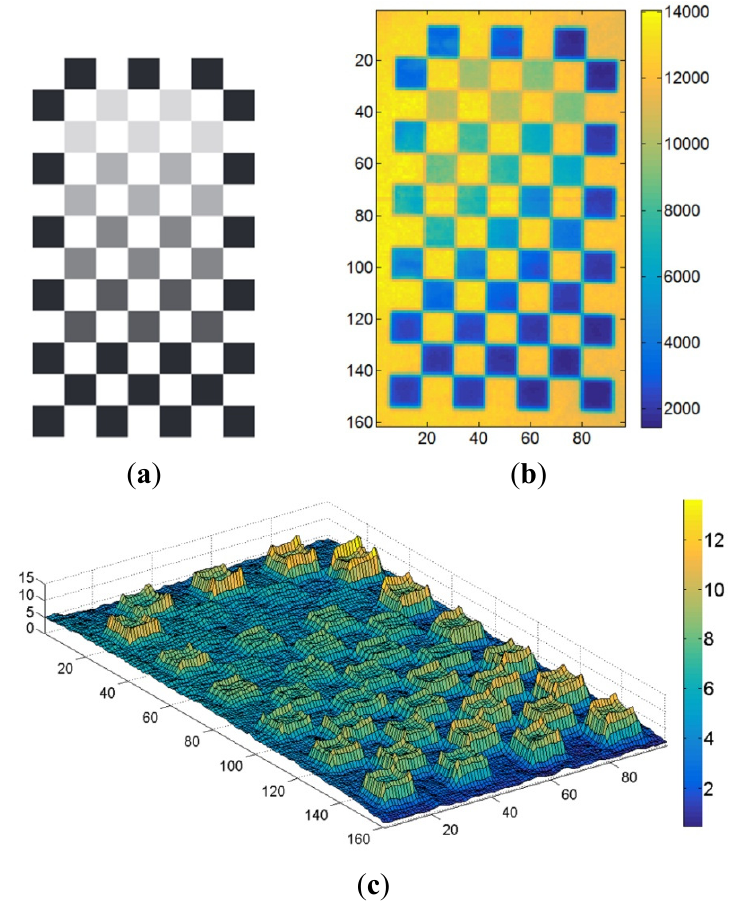
Figure 4. ( a ) Checkerboard of grey levels inspired from [38], ( b ) intensity values measured on this checkerboard, and ( c ) corresponding 3D representation of distance measurements variations (in